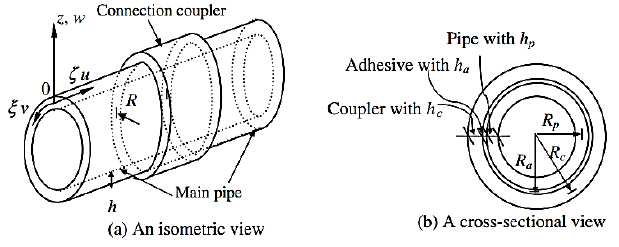
Figure 11. Schematic of adhesive joint with piezoelectric layer in coupler proposed by Cheng et al.